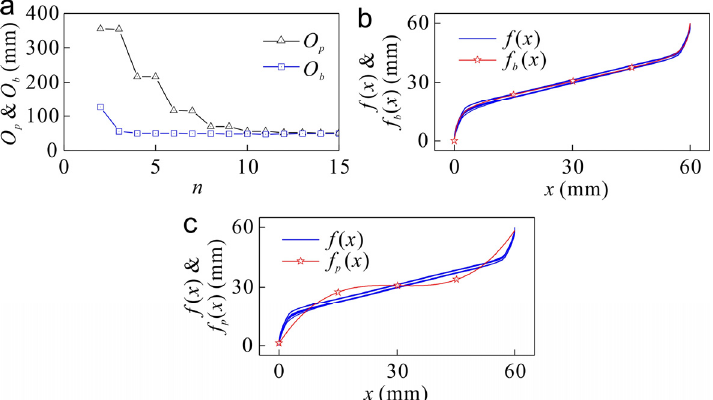
e b = f ( x ) − f b ( x ) . p i and w i are design variables and constrained to [ 0, 60 ] and [ 1, 60 ] , respectively, and the optimal results are displayed in Figure 3a,b.